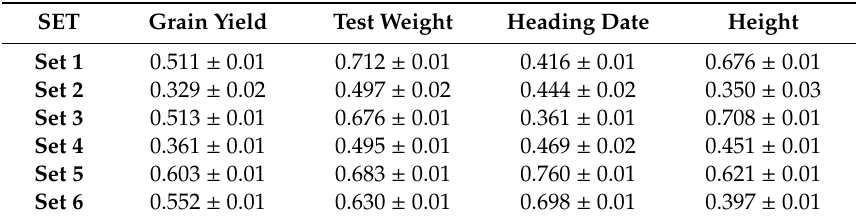
Table 1. Means and standard errors of prediction accuracy of the di ff erent traits for the six wheat (days after 1 January) and height (cm).